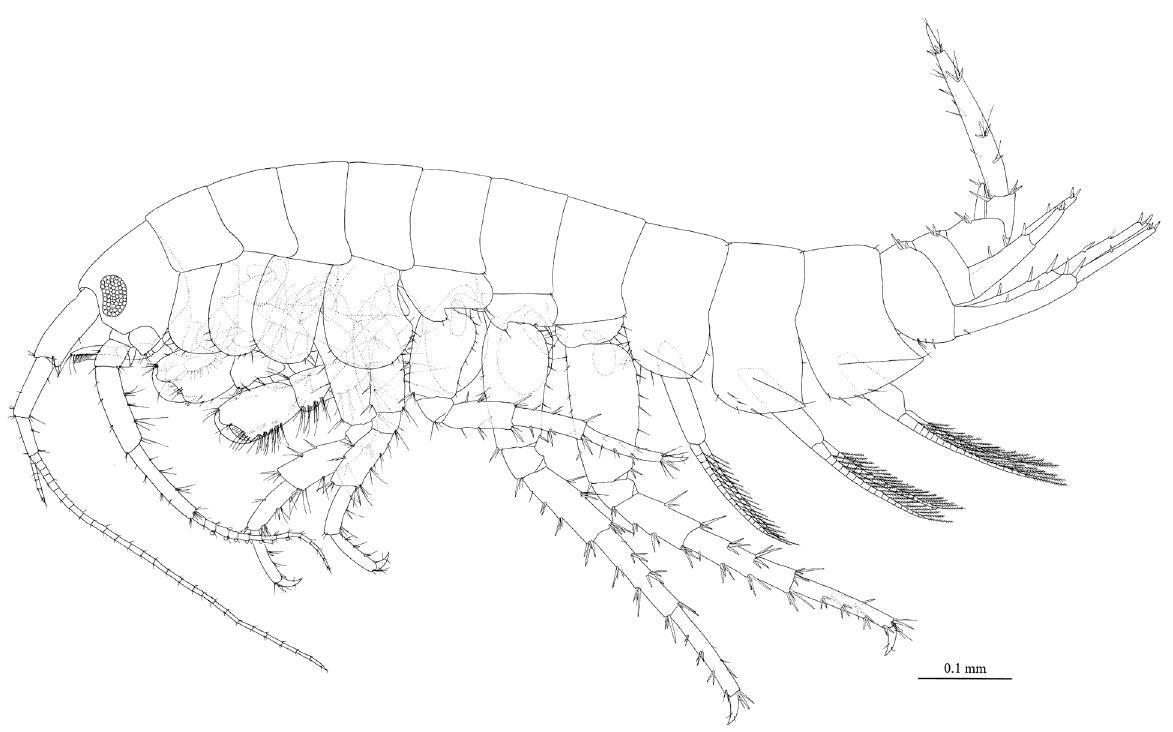
Figure 9. Jesogammarus uchiyamaryui sp. n., holotype, male (10.3 mm), NSMT-Cr 25474. Habitus, lateral